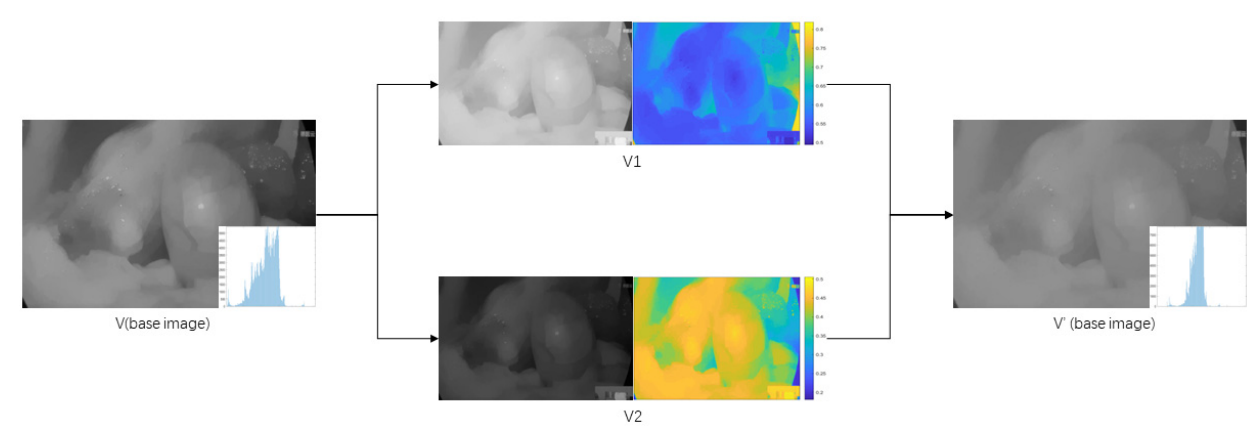
Figure 3. Brightness Correction Flowchart.